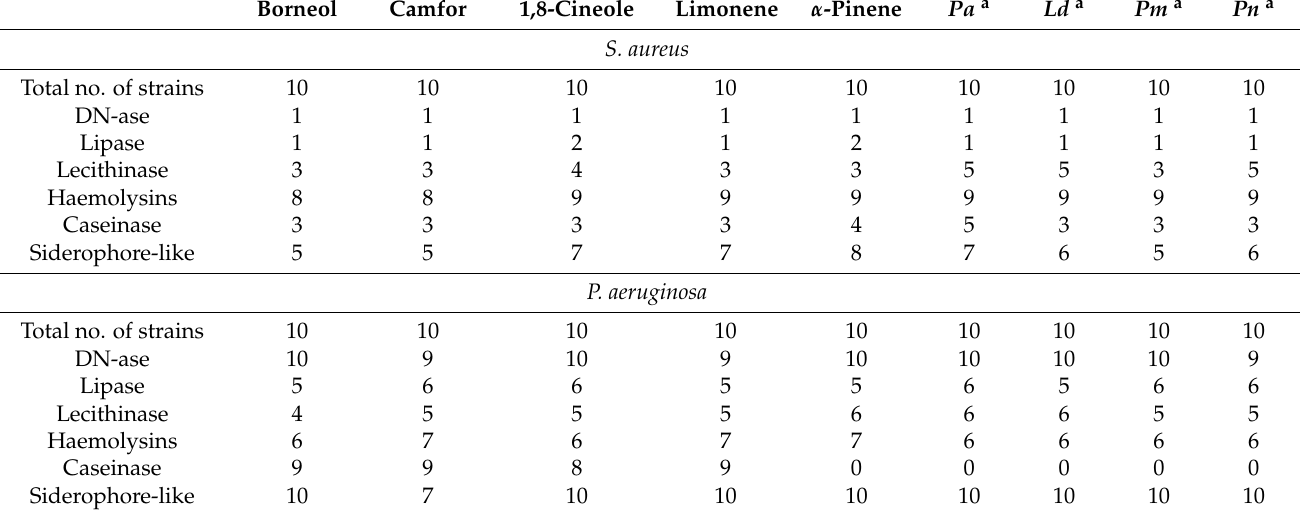
Table 4. The number of strains in which the inhibition of at least one virulence factor expression was noticed in the presence of the EOs and of their major